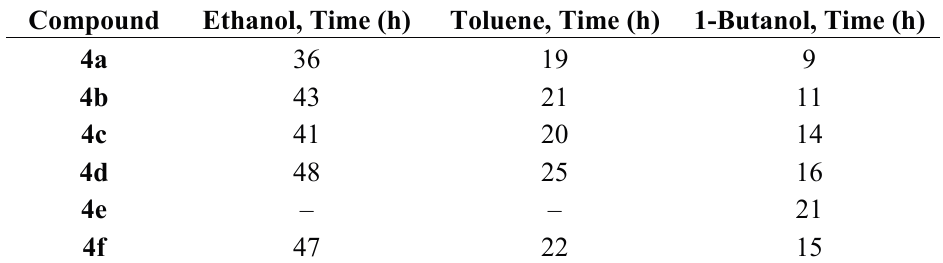
Table 1. Synthesis of 1-(3-nitrophenyl)-5,6-dihydro-4 H -[1,2,4]triazolo[4,3- a ][1,5] benzodiazepines 4a – f in different solvents.